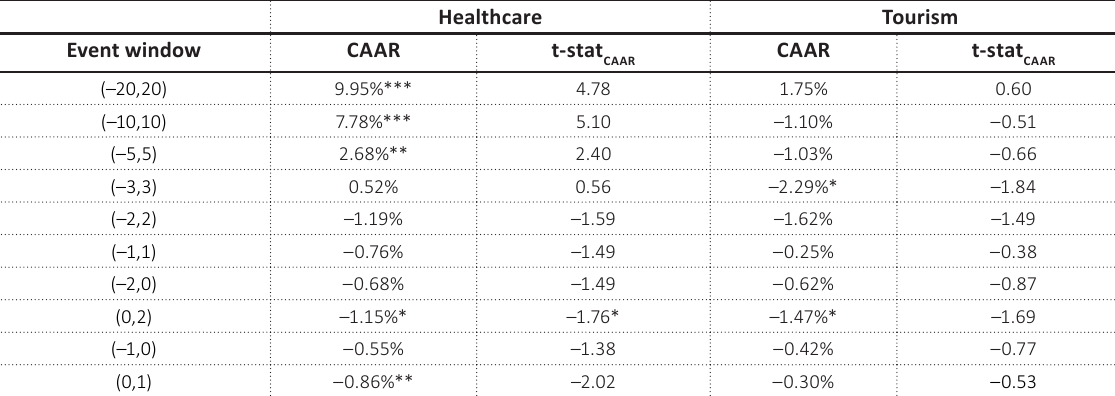
Table 2. Cumulative Average Abnormal Returns of healthcare and tourism sectors surrounding the first reported COVID-19 case